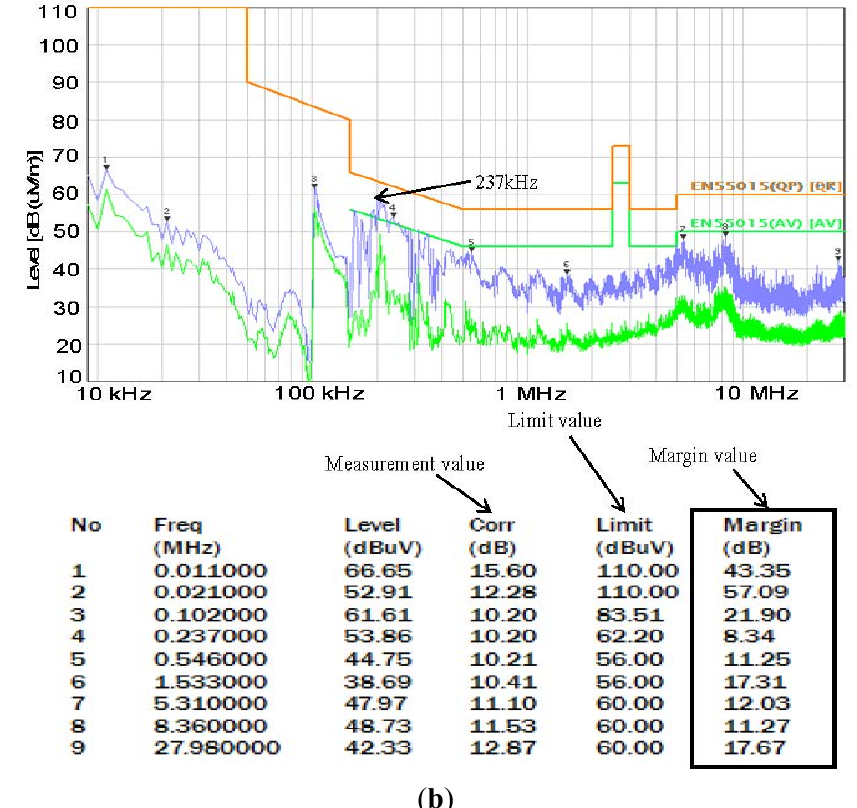
Figure 25. EMI test results. ( a ) EMI RE Test result; ( b ) EMI CE Test